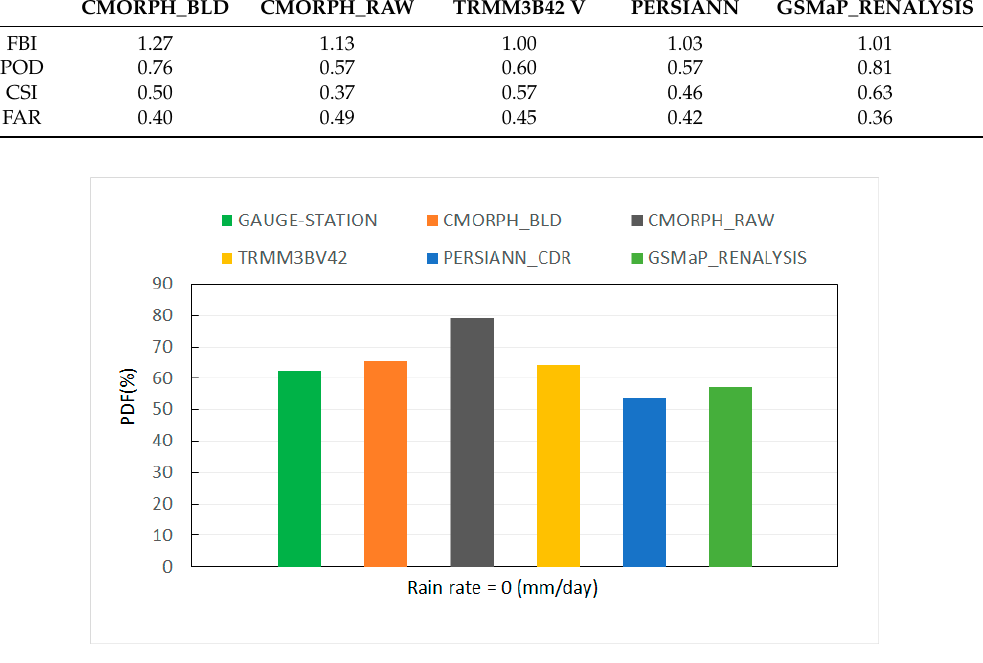
Figure 7. Probability density function of daily rainfall for the no-rain case.